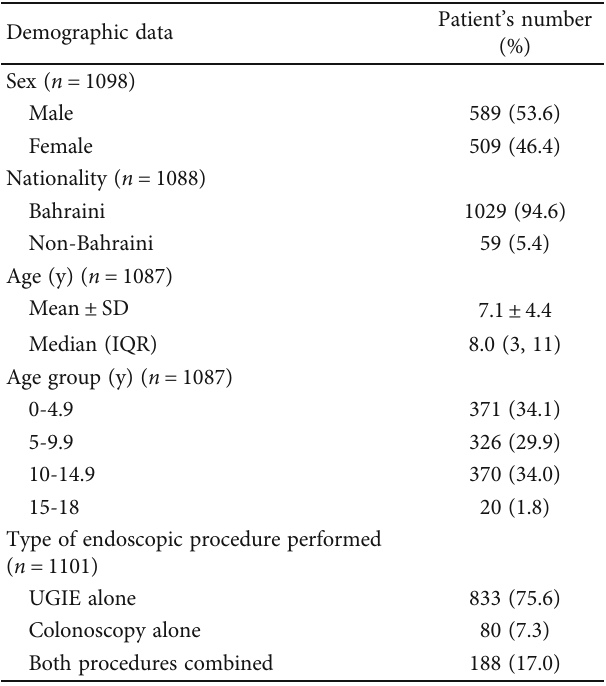
Table 1: Demographic data of pediatric patients who underwent gastrointestinal endoscopy ( n = 1,101